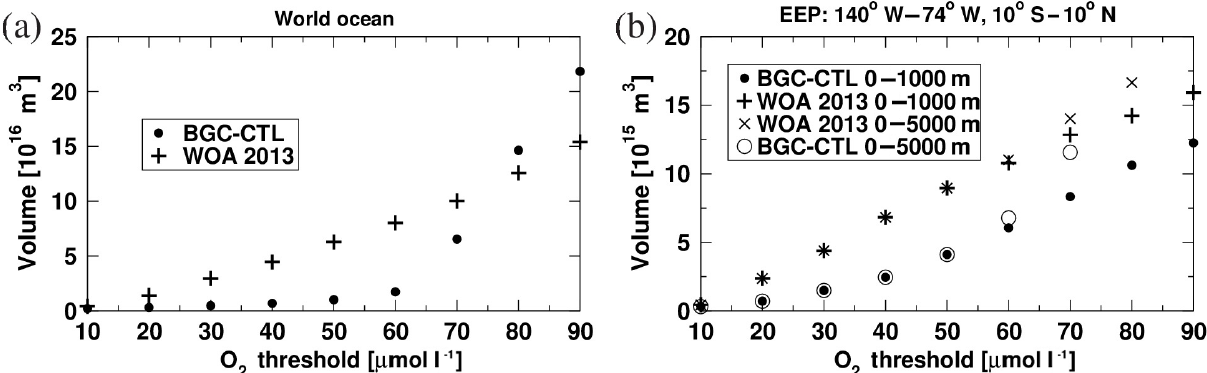
Figure A2. Simulated and observation-based (WOA2013, Garcia et al., 2013) volume of water masses with oxygen concentration below the threshold value indicated on the x -axis for (a) the world ocean from the surface to the seafloor in 10 15 m 3 , and (b) the EEP for 0–1000 and 0–5000m in 10 14 m 3 . See legends for explanations of symbols.